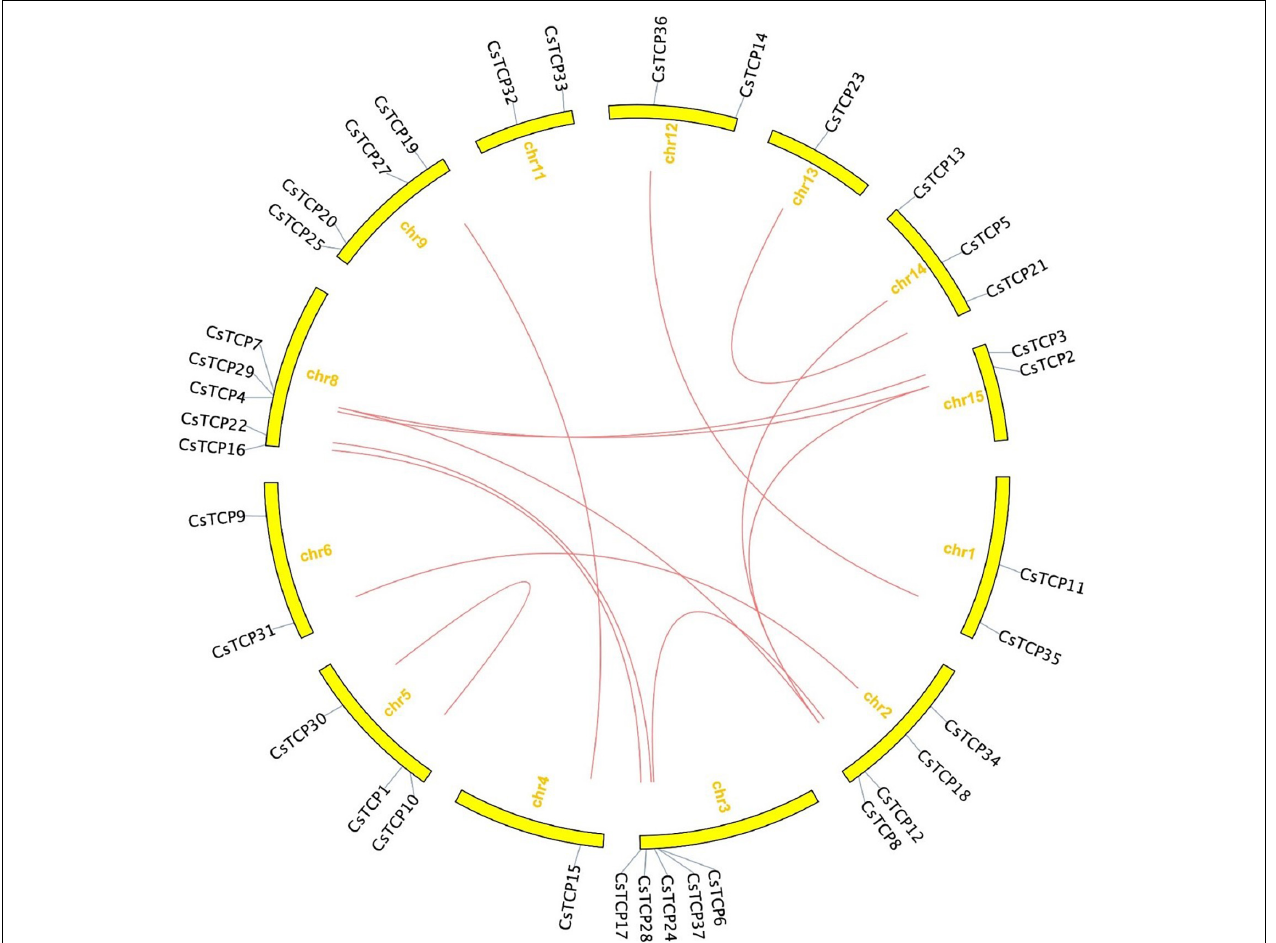
FIGURE 5 | Syntenic genes among TCP gene family from Camellia